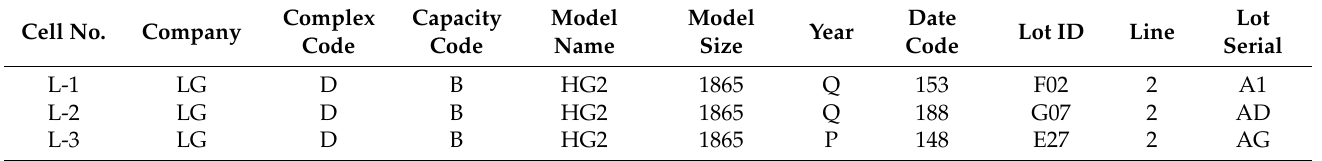
Table 1. Comparison of the text printed on the outer casing of the three batteries.